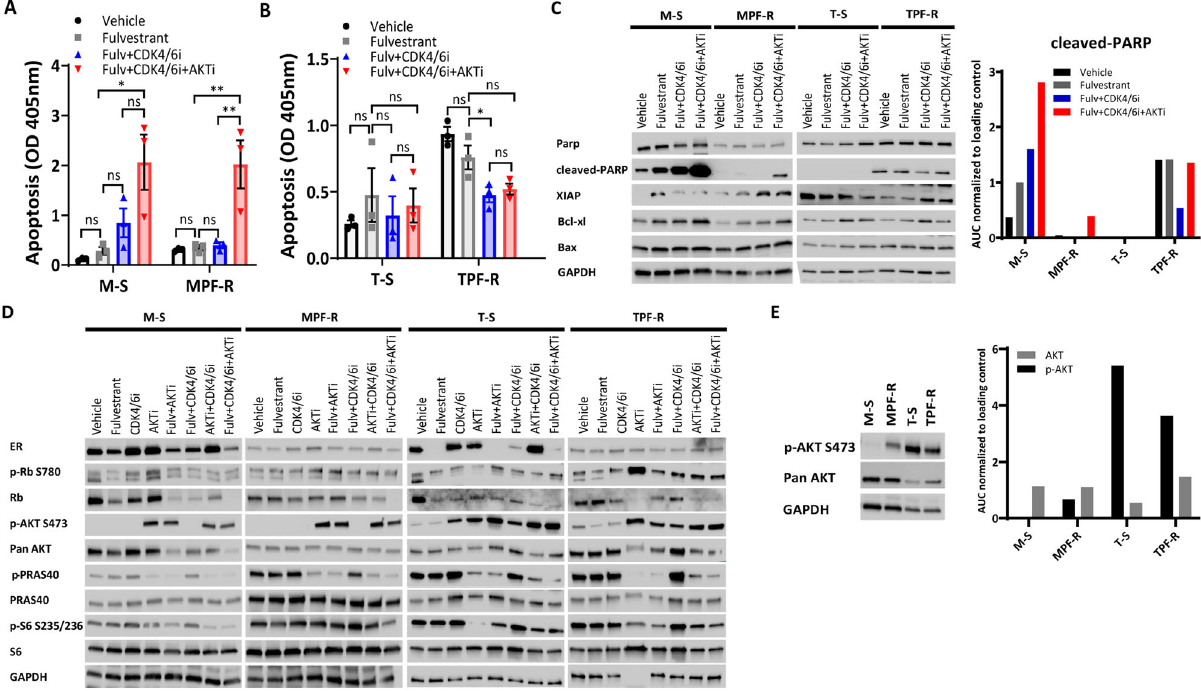
Fig. 5 Combined targeting of ER, CDK4/6 and AKT ef fi ciently inhibits cyclin D/CDK4-6/Rb and PI3K/AKT-mTOR pathways in breast cancer cells resistant to combined CDK4/6i and fulvestrant. Apoptotic levels were determined by evaluating the presence of cytoplasmic nucleosomes in MCF-7 ( A ) and T47D ( B ) cell models using an ELISA cell death detection assay. Data are shown with error bars representing mean ± SEM of three biological replicates. Asterisks indicate signi fi cant differences in one-way ANOVA tests (*0.01 < p < 0.05, **0.001 < p < 0.01, ***0.0001 < p < 0.001, and **** p < 0.0001). C Western blot analysis of apoptosis markers in both models resistant to combined fulvestrant and CDK4/6i. Densitometry analysis of Western blot bands of cleaved-PARP was performed using ImageJ software. Data are shown as the area under the curve (AUC) normalized to loading control. D Western blot analysis of key signal transduction proteins in breast cancer cell models resistant to combined CDK4/6i and fulvestrant therapy. E Western blotting analysis of p-AKT (S473) and total AKT expression in both breast cancer models resistant to combined fulvestrant and CDK4/6i. Densitometry analysis of Western blot bands of p-AKT (S473) and total AKT was performed using ImageJ software. Data are shown as the area under the curve (AUC) normalized to loading control. GAPDH was used as a loading control for Western blotting analysis. For all Western blots, a representative of two biological replicates is shown. Both apoptosis assay and harvesting protein for Western blotting analysis were performed 3 days after treatment with fulvestrant (Fulv, 100 nM), CDK4/6 inhibitor (CDK4/6i, palbociclib, 200 nM), and AKT inhibitor (AKTi, capivasertib, 250 nM in the MCF-7 cell model; 100 nM in the T47D cell